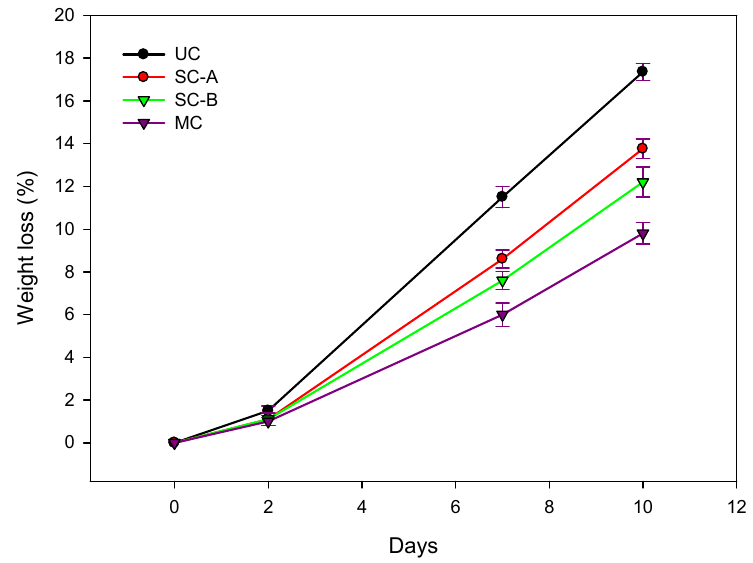
Figure 2. Weight loss of sliced cherimoya with different treatments: uncoated samples (UC), single coating A (SC-A), single coating B (SC-B), and multilayered coating (MC). N = 3; data shown are mean ± standard deviation.